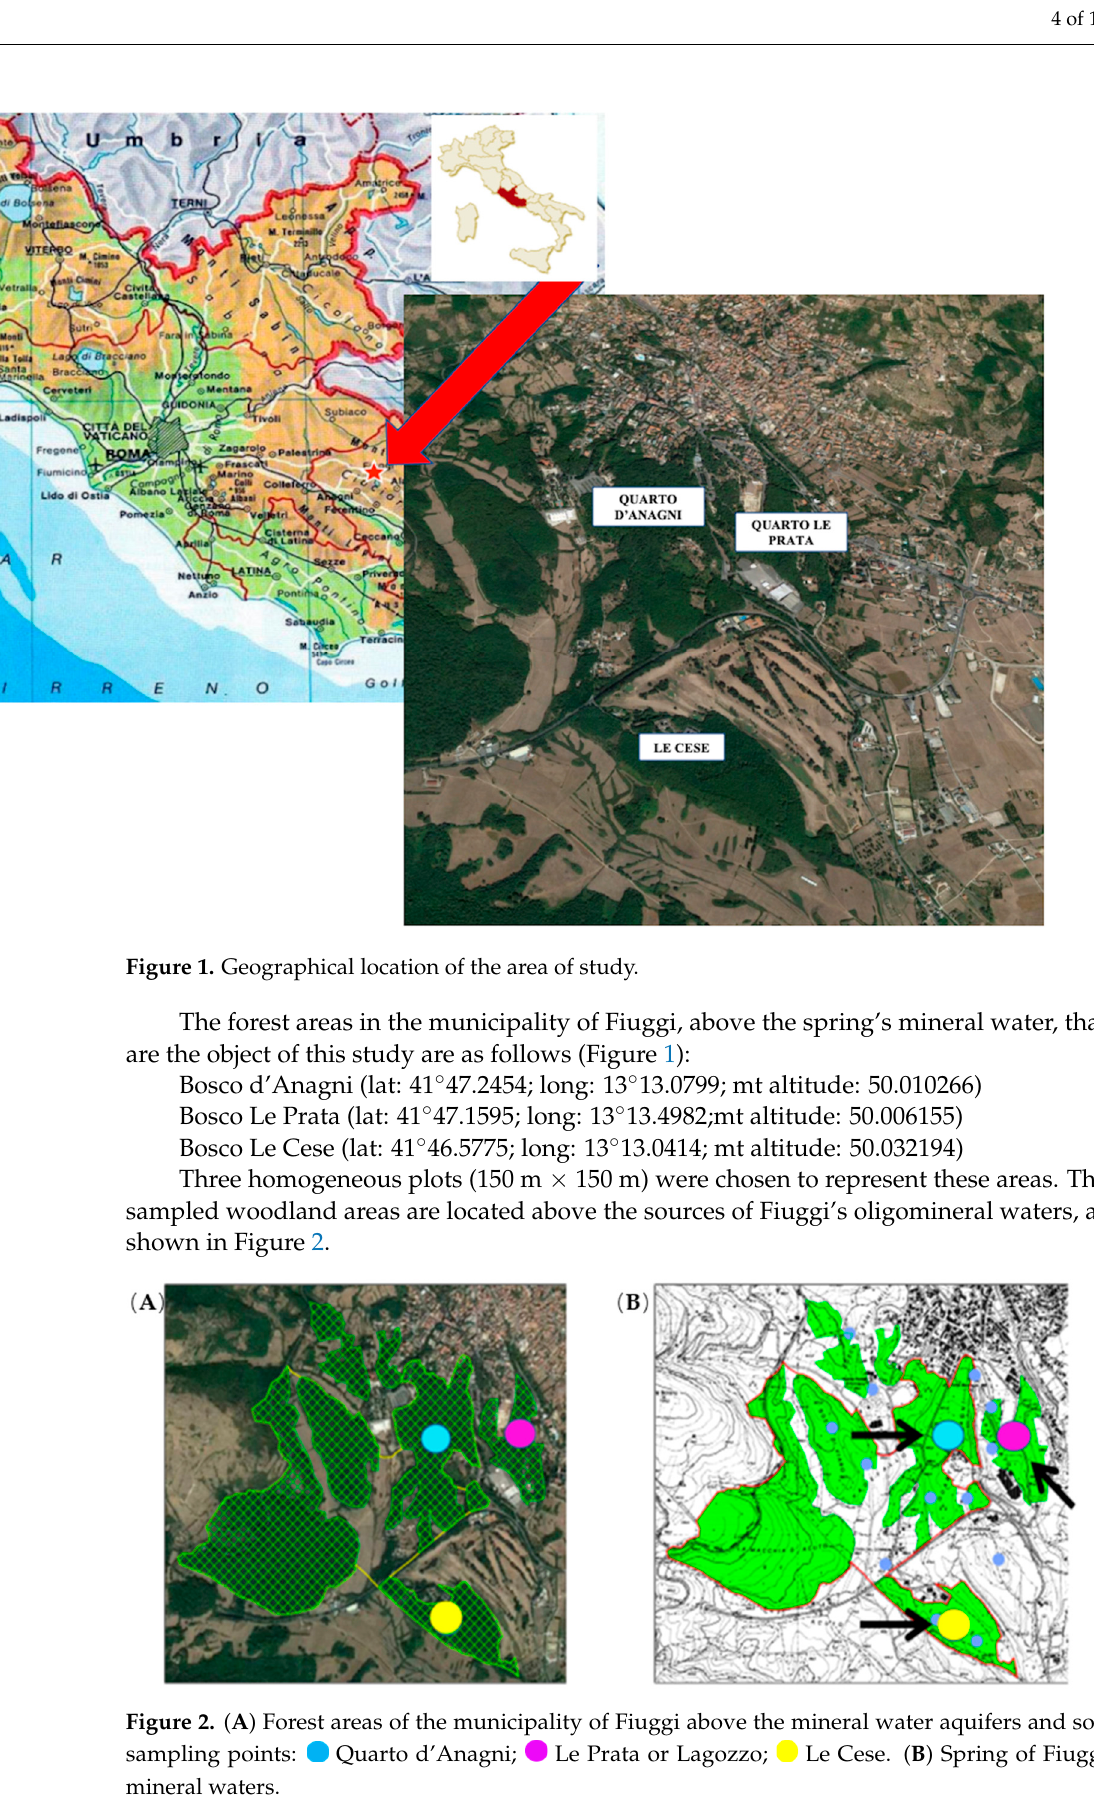
Le Cese. ( B ) Spring of